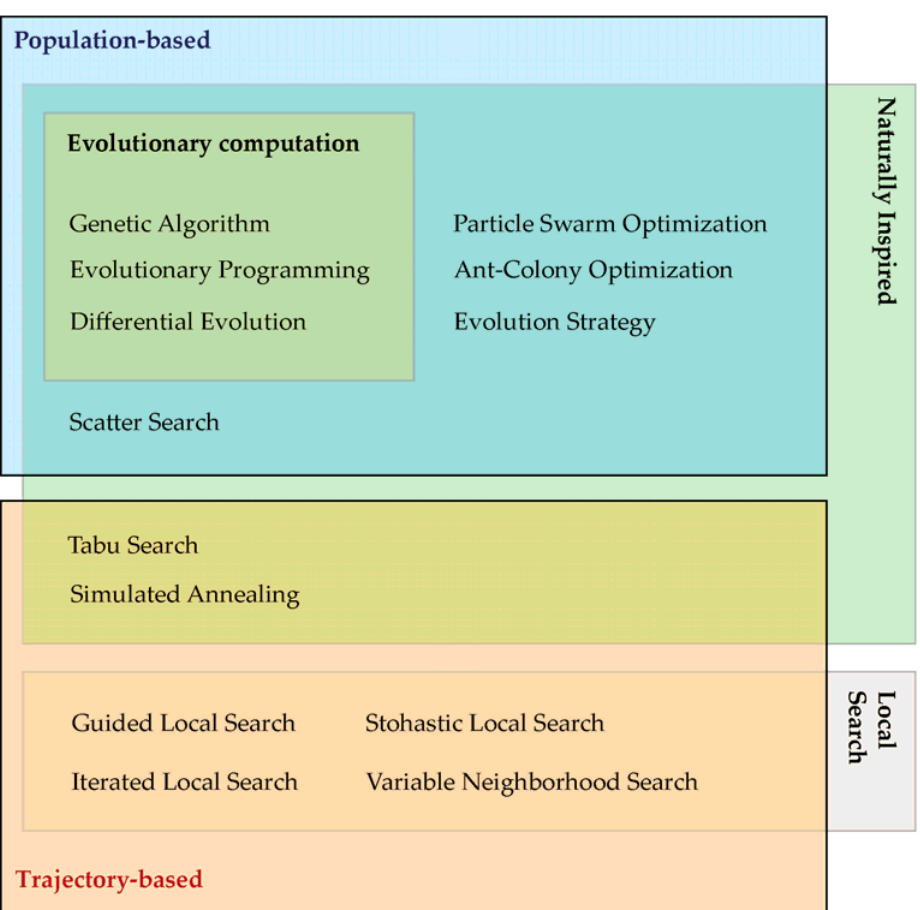
Figure 3. Metaheuristic methods classification.